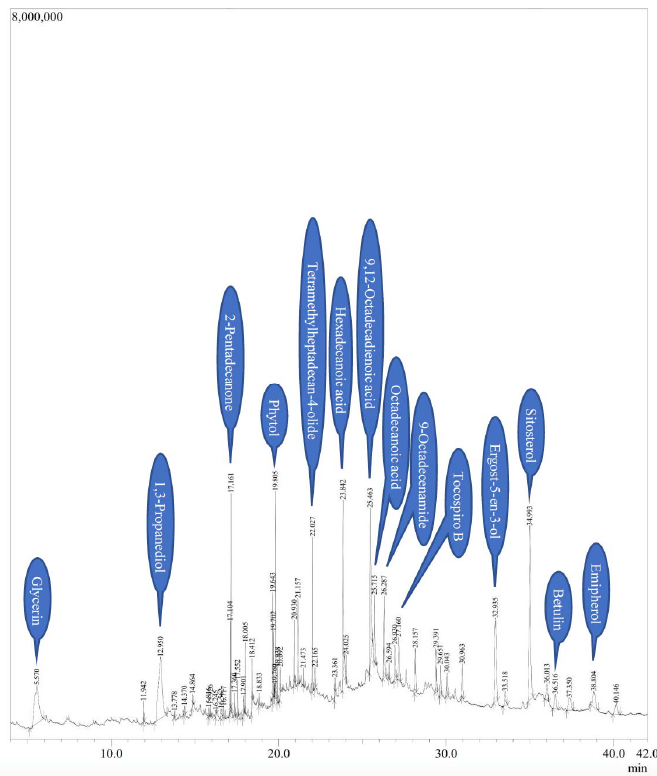
Figure 6. Phytoconstituents detected in the methanol leaf extract of a four-week-old in vitro- propagated plantlet of D. palmatus using